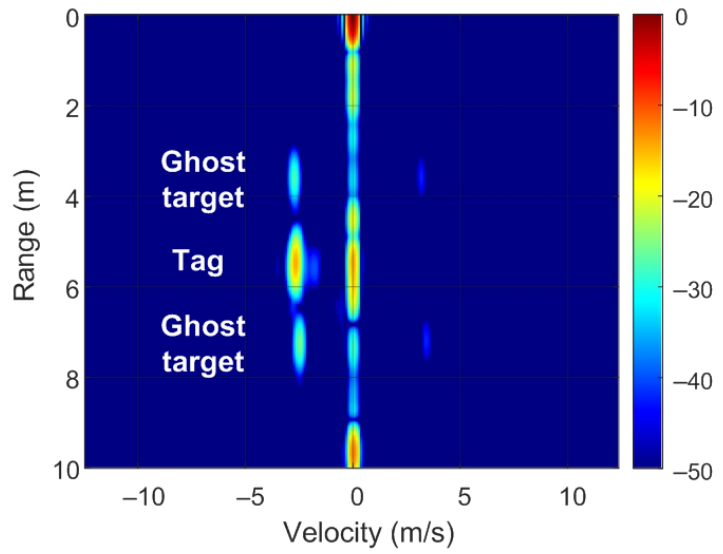
Figure 19. Measured range–Doppler map including two ghost targets at 2.5 m with the tag approach- ing the radar.